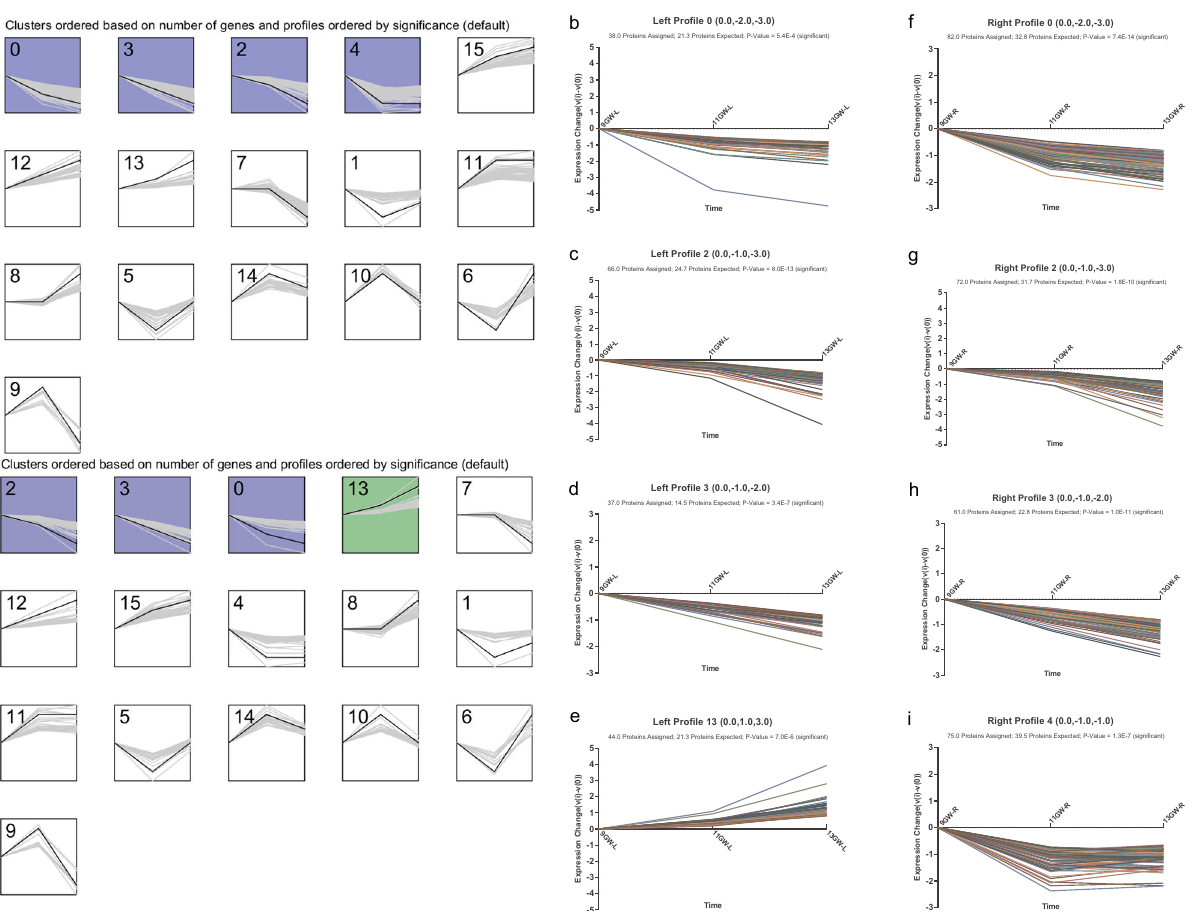
Fig. 5 Short time-series expression miner (STEM) analysis of proteins in the bilateral frontal lobes. a ResultsoftheSTEManalysisofcoreproteinsintheleft and right frontal lobes. The upper left corner represents the pro fi le ID. The black line displays the model expression of each pro fi le. The gray lines represent all single gene expression pro fi les. The x axis represents time: 9, 11, and 13GW. Signi fi cantly enriched clusters are indicated by different colors ( p <0.05). No signi fi cant differencewasfoundintheexpressionofclusterslabeledwhite. b Theexpressionofproteinsincluster0ontheleftside(38assigned)graduallydecreased,andtherate of downregulation decreased with increasing age. c The expression of proteins in cluster 2 on the left side (66 assigned) gradually decreased, and the rate of downregulation increased with increasing age. d The expression of proteins in cluster 3 on the left side (37 assigned) gradually decreased with increasing age. e The expression of proteins in cluster 13 on the left side (44 assigned) gradually increased, and the rate of upregulation increased with increasing age. f The expression of proteins in cluster 0 on the right side (82 assigned) gradually decreased, and the rate of downregulation decreased with increasing age. g The expression of proteins in cluster 2 on the right side(72 assigned) gradually decreased,and the rateof downregulation increased with increasing age. h The expression of proteins in cluster 3 on the right side (61 assigned) gradually decreased with increasing age. i The expression of proteins in cluster 4 on the right side (75 assigned) gradually decreased from GW 9 to 11, and almost no change was found between GW 11 and 13. GW